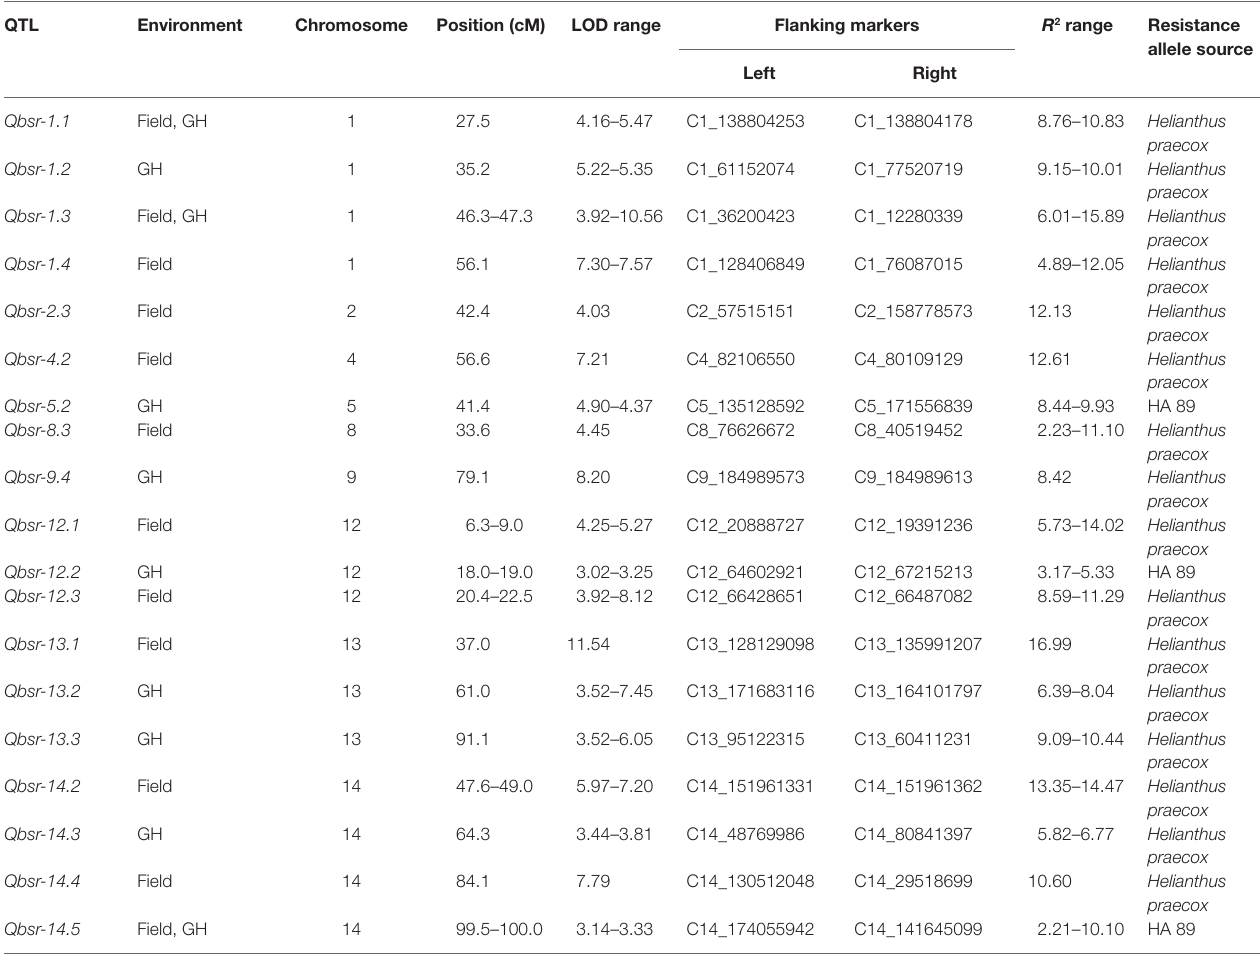
TABLE 5 | Summary of Sclerotinia basal stalk rot resistance QTL identified in the HA 89/ Helianthus praecox AB-QTL